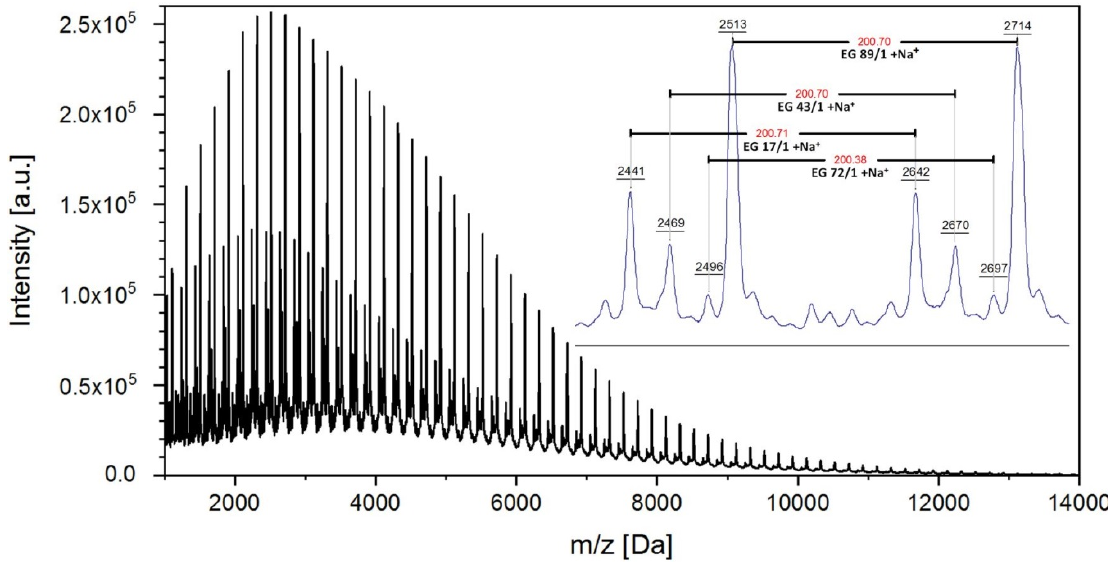
Figure 3. MALDI/TOF-MS spectrum of PBA6 (EG: end